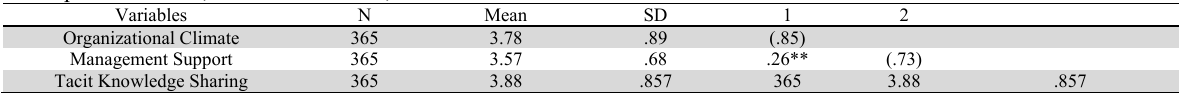
Descriptive Statistics, Scale Reliabilities, and Correlation of